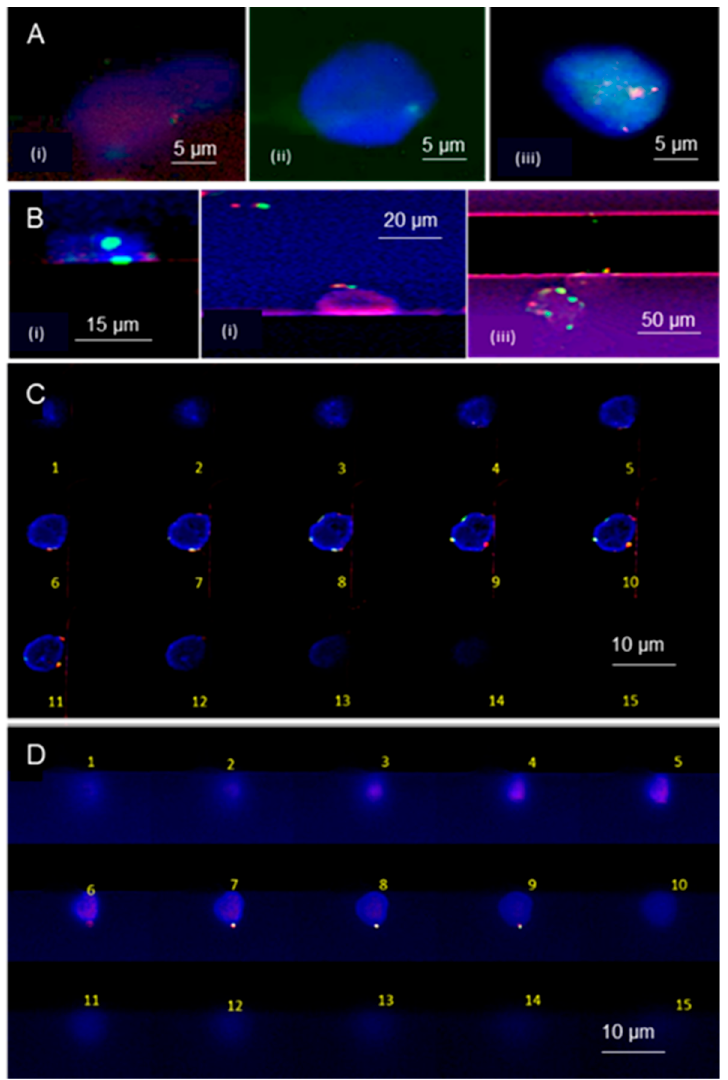
Figure 6. FISH-on-chip analysis of RPMI-8226 and SUP-B15 cells. ( A ) RPMI-8226 cells after FISH processing using the microtrap chip with the D13S319 plus deletion probe; (i) a cell that shows one green and one red FISH signal; (ii) a cell with only one green signal; (iii) a cell with 2 green and 2 red signals. ( B ) FISH analysis of SUP-B15 cells processed with the TEL/AML1 translocation, dual fusion probes showing the TEL (ETV6, 12p13.2) region in red, and AML1 (RUNX1, 21q22.12) region in green. (i) Two cells contained at the entrance of two different microtraps, but the FISH probes were visible in only one cell with two green signals; (ii) shows one red and two green signals with no clear yellow signals present; (iii) two cells that show distinct red and green signals, one cell captured at the entrance of microtrap shows one red, and one green signal with a possible yellow fusion signal. Both ( A , B ) were imaged in one single z-plane without z-stacking. ( C , D ) show z-stacking planes of 15 different image planes for FISH images from SUP-B15 cells captured at the microtrap and FISH processed with BCR/ABL plus translocation, dual fusion probe. ( C ) SUP-B15 cell with two green and two red signals. ( D ) SUP-B15 cell with one yellow fusion signal (second yellow signal not visible) and one red and green signal. Each image shows 15 separate images through the 15 µ m distance range taken at 1- µ m imaging intervals. FISH probes were specific to the BCR / ABL gene region, Philadelphia (Ph) chromosome tagging. All images were acquired using a Nikon 60 × oil objective with DAPI—200 ms, FITC—1500 ms, TRITC—2500 ms integration times. The average SNR was 59 for the green probe and 68 for the red probe.